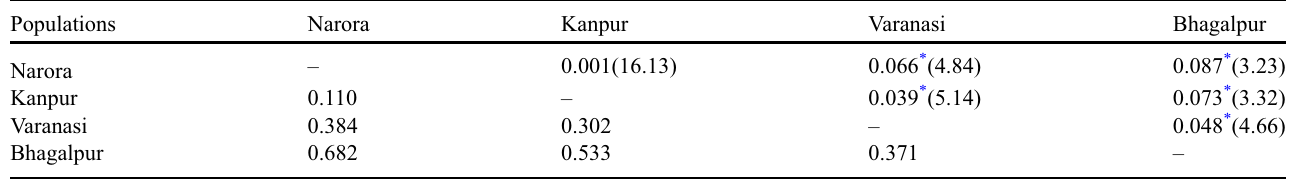
Table 3. Fisher ’ s pair-wise F ST (above diagonal), gene fl ow N M (between parenthesis), and Nei ’ s unbiased genetic distance (below diagonal) of all the studied loci for populations of Sperata aor .